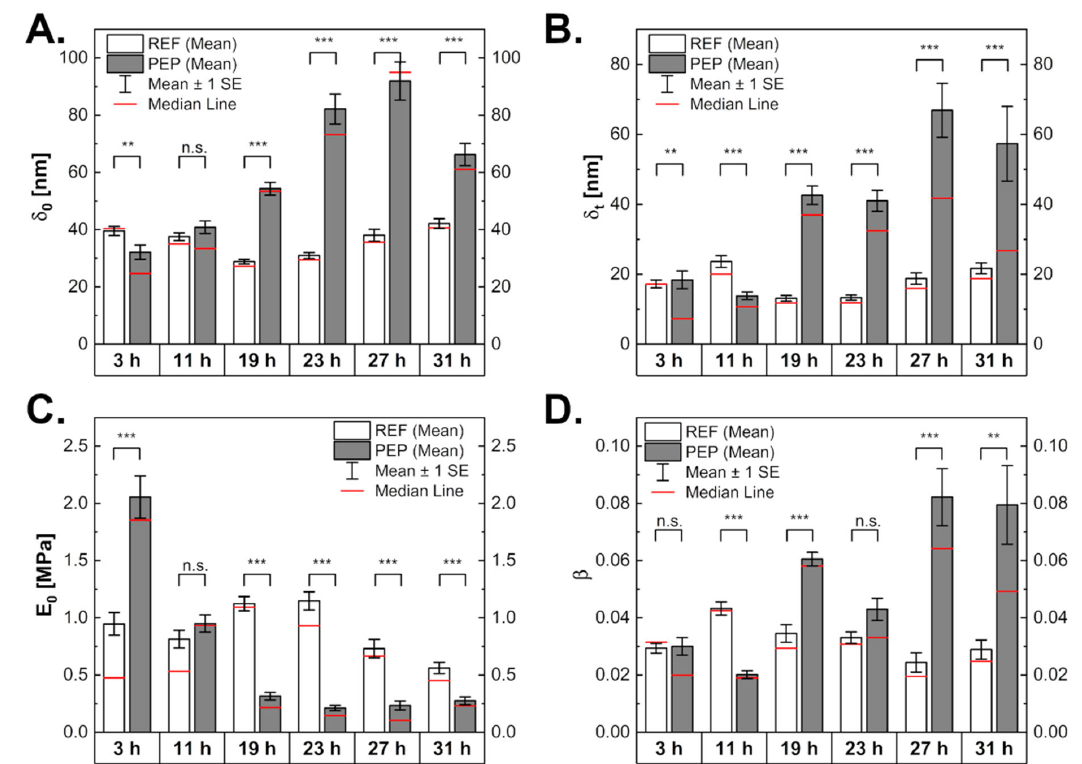
Figure 6. Viscoelastic properties of bacteria from creep experiments shown as initial deformation ( A ), creep magnitude ( B ), relaxation modulus ( C ), and power law exponent ( D ). The number of measurements over 3 to 31 h for the reference cells was 74, 83, 58, 66, 26, and 43, and for the peptide ‐ producing cells, it was 77, 65, 78, 68, 55, and 42. N.s. indicates non ‐ statistically significant differences, ** with p ‐ value < 0.01 and *** with p ‐ value < 0.001.